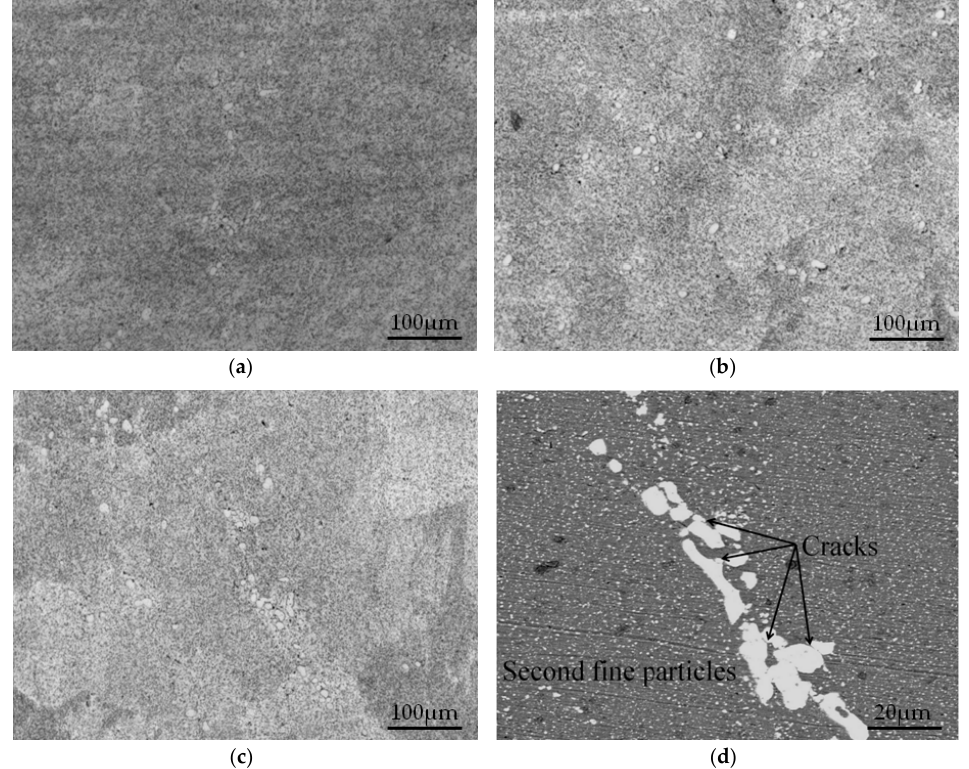
Figure 5. Micrographs of 2219 aluminum alloys with different Cu contents processed by multi-directional forging (MDF): Optical images ( a ) 5.56%, ( b ) 6.15%, ( c ) 6.52%, and ( d ) SEM image of un-dissolved coarse particles in 2219-6.52Cu alloy .